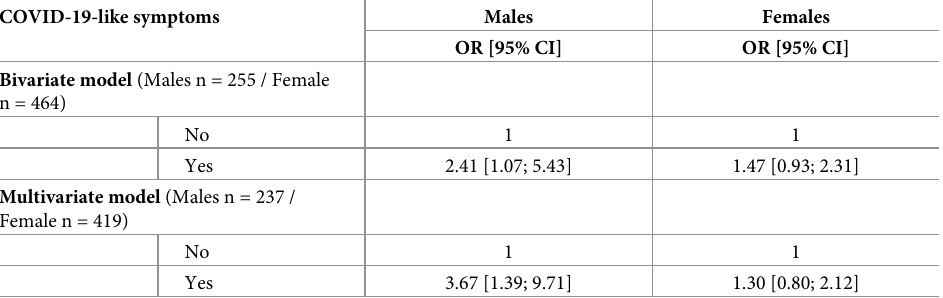
Table 4. Sex stratified bivariate and multivariate GEE models of anxiety/depression problems and absence/pres- ence of COVID-19-like symptoms. COVID-19-like symptoms